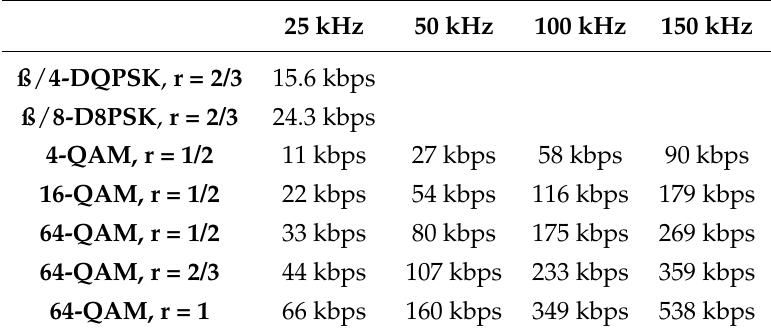
Table 1. Channel coding and TETRA Enhanced Data Service (TEDS)